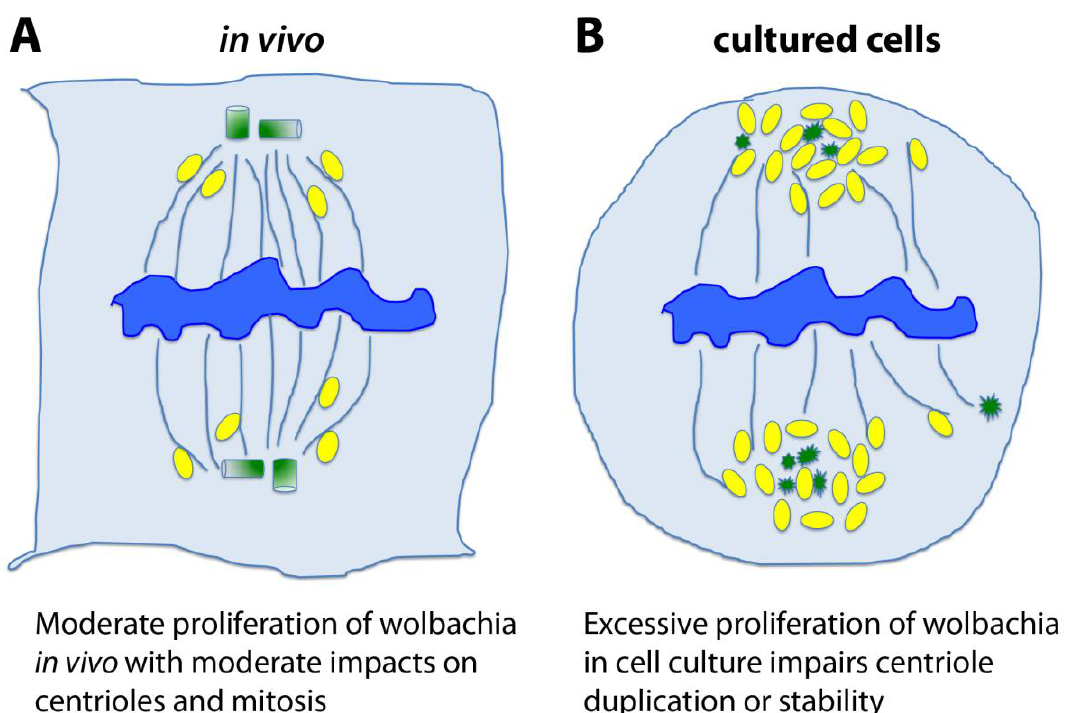
Figure 3. Hypothesis 3: chronic and excessive Wolbachia infection causes centriole loss in cell culture. A . Wolbachia are intracellular bacteria that infect many Drosophila strains and, in particular, the original stock from which the mh 1 mutation was isolated. In physiological conditions, these bacteria depend on their cell host survival and their proliferation is moderate. The microbes associate with and traffic upon the microtubule (MT) cytoskeleton, and even if they associate with the poles of the mitotic spindle they do not typically cause centriole loss in vivo. B. In cultured cell lines, Wolbachia seems to be out of control and tend to overproliferate. As many Wolbachia bacteria gather towards spindle poles, it is possible that their overwhelming presence leads to the disruption of the centrosome and centriole instability. In these schematics, the chromosomes are blue, the MTs are blue threads, centrioles or degraded centrioles are green, and Wolbachia are yellow ovals.